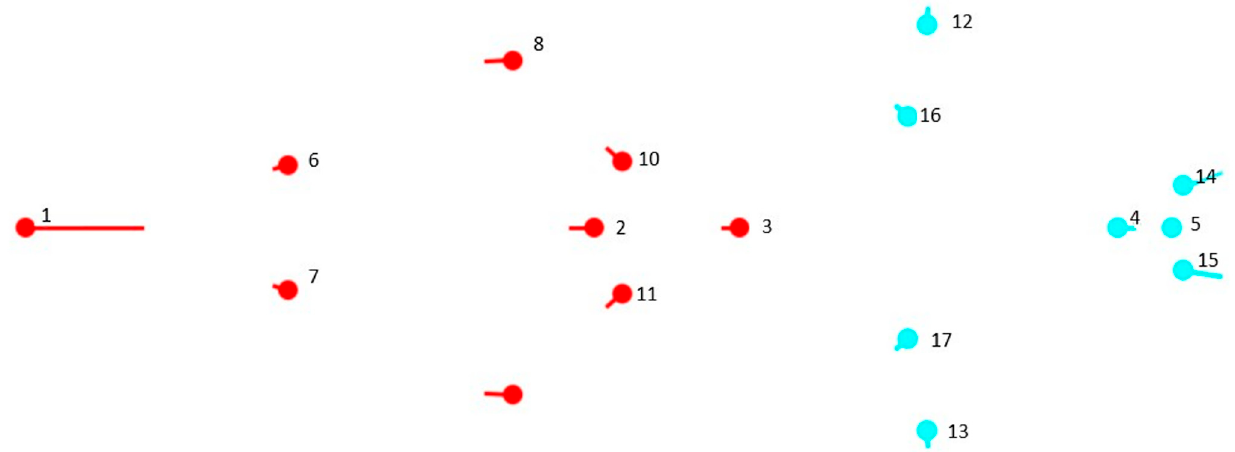
Figure 5. Covariation between modules for module PLS1. There is a slight lateral expansion in the zygomatic and parasagittal portion of the occipital condyles and caudal face shortening in the visceral portion.